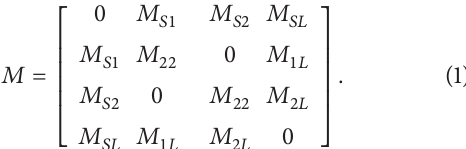
Figure 4 shows the proposed capacitive and inductive S- L couplings and coupling topology, where the empty disks represent the source and load, respectively. The solid disks represent the odd-mode and even-mode. The input signal is coupled to two modes using coupled-line coupling [12] (represented by the solid lines), as is the output signal. The dashed lines represent the S-L couplings. The coupling topology is analyzed by means of the coupling matrix 𝑀